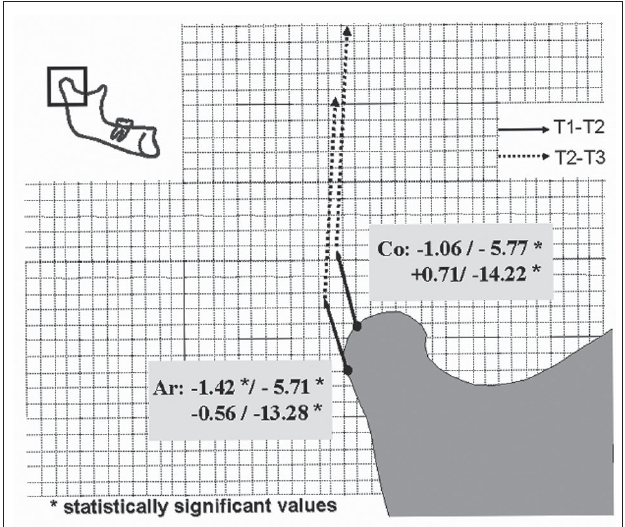
Fig. 4 . Condylar remodeling between T1 and T2 (upper data) and between T2 and T3 (lower data). The horizontal/vertical components are proportional in scale. Each square represents 1 mm.